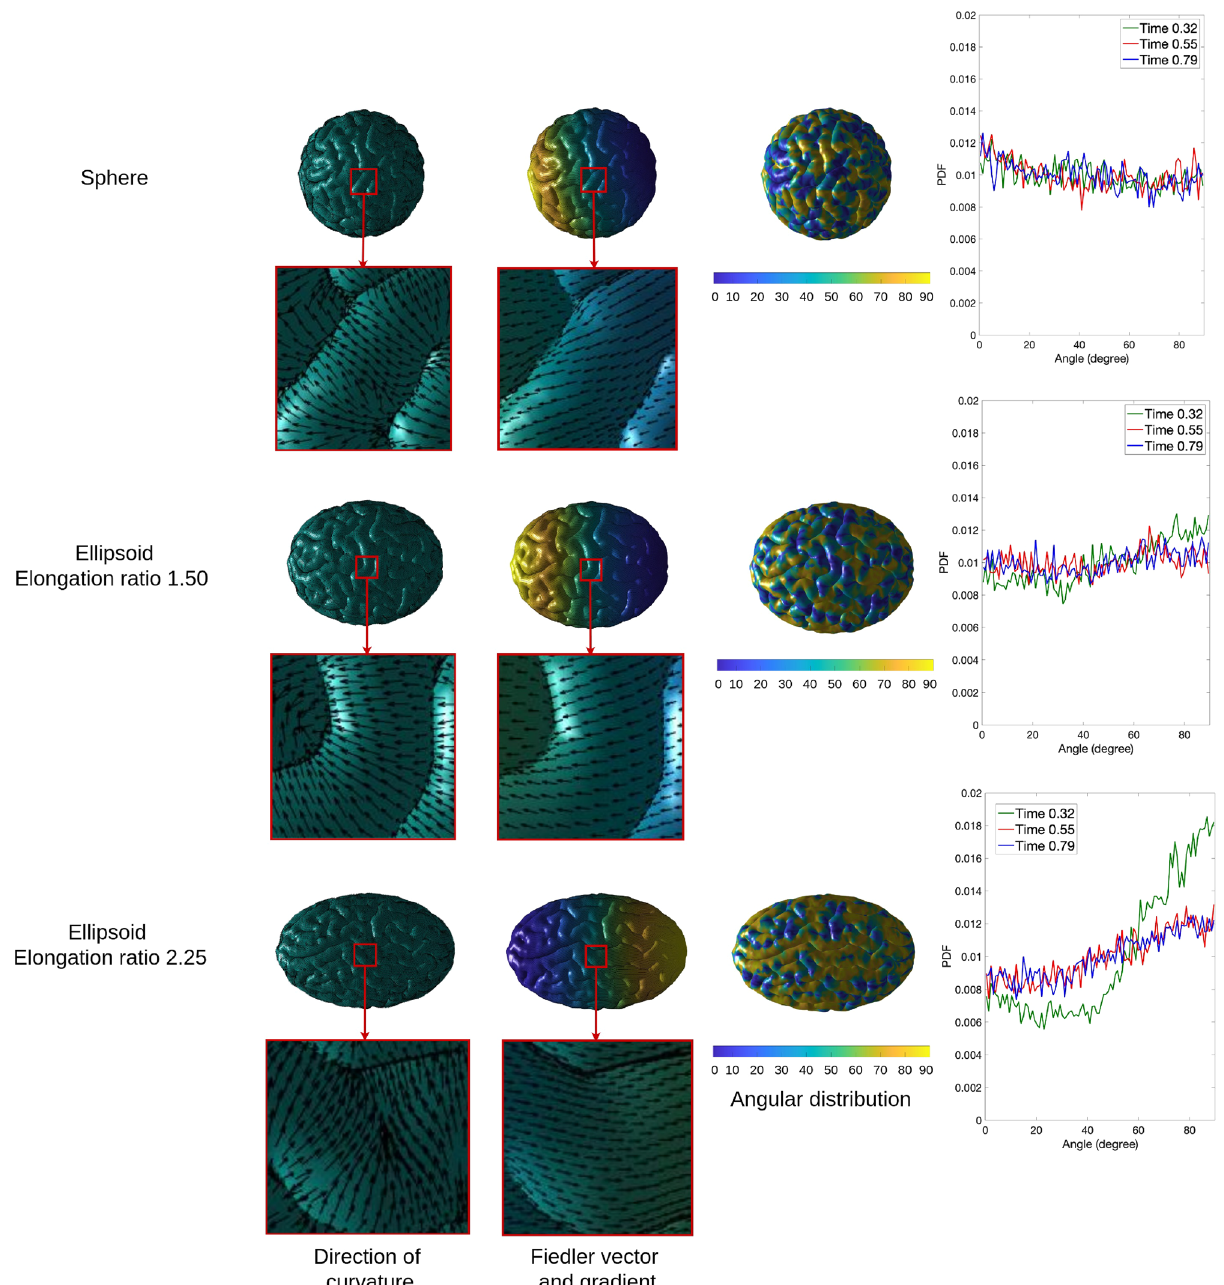
Figure 8. Illustration of principal directions of curvatures, gradients of Fiedler vectors, and angular distributions for surface of sphere, ellipsoid of elongation ratio 1.50 and ellipsoid of elongation ratio 2.25 at time 0.32, 0.55 and 0.79. Software: MATLAB R2019b, https:// www. mathw orks.